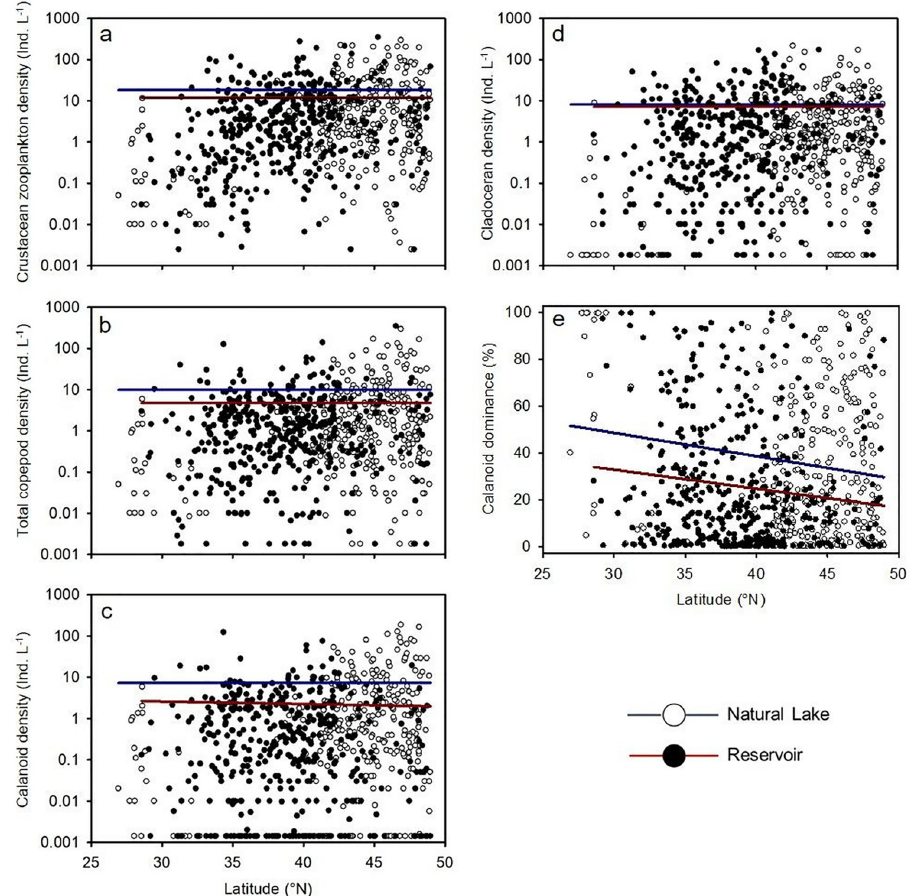
Fig 2. U.S.-scale comparisons of a) crustacean zooplankton (copepod + cladoceran), b) total copepod (cyclopoid + calanoid), c) calanoid, and d) cladoceran density, and e) calanoid dominance in the zooplankton community between natural lakes and reservoirs and across latitude. Note that the y-axis is in log scale for the zooplankton density panels.